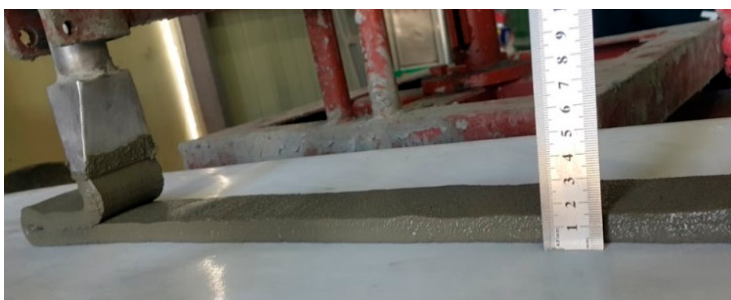
Figure 1. View of the 3D concrete printing (3DCP) process for buildability testing [15].